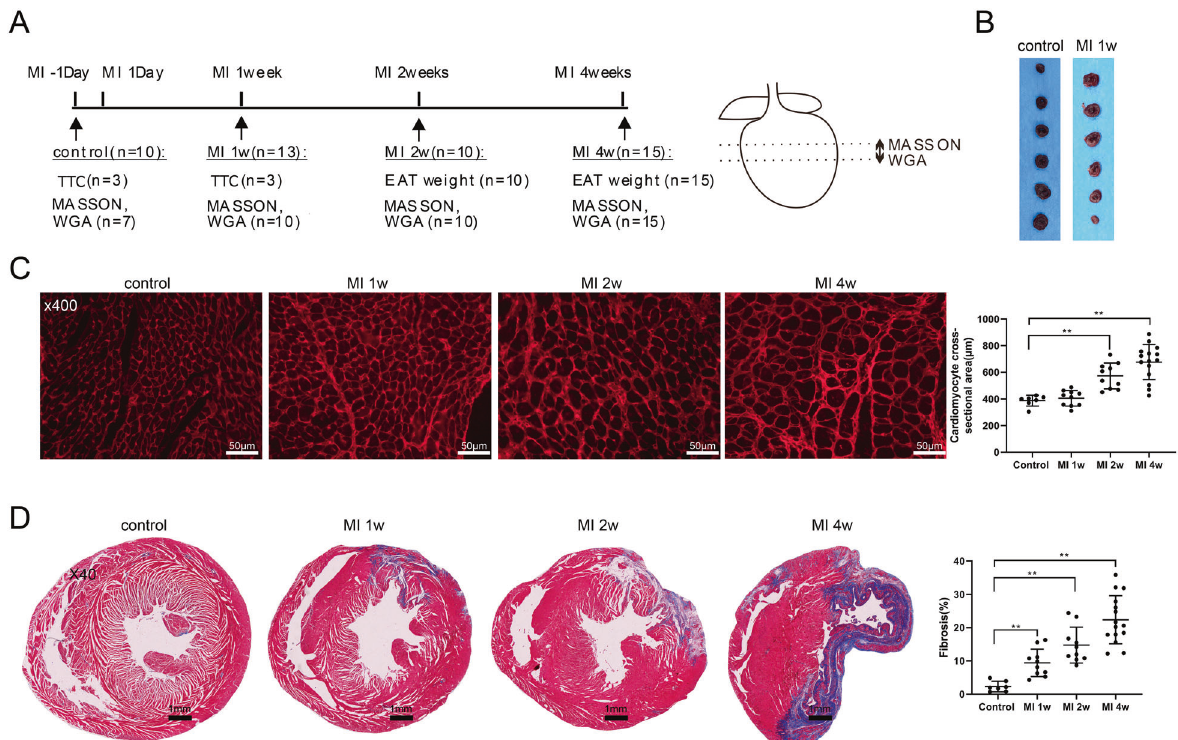
Fig. 1 Adverse myocardial remodeling in the rat model of myocardial infarction (MI). A Left: experimental protocols of control ( n = 10), MI 1-week ( n = 13), MI 2-week ( n = 10), and MI 4-week ( n = 15) groups. Right: wheat germ agglutinin (WGA) staining and Masson ’ s trichrome staining were carried out with the tissue at the location indicated by the dotted line. B Representative cardiac slices of rats with infarcts stained by 2,3,5-triphenyl tetrazolium chloride (TTC) in the control and MI 1-week groups. C Cardiomyocyte cross-sectional areas were examined using WGA staining (scale bar = 50 µm). D Myocardial fi brosis was examined using Masson ’ s trichrome staining (scale bar = 1 mm). ** P <